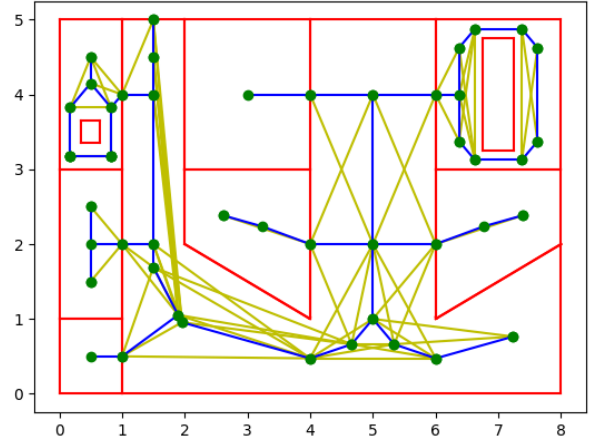
Figure 1. The navigation network for a case study floor. Edges are of two kinds: coming from the straight skeleton (in blue) and from the visibility graph (in green)